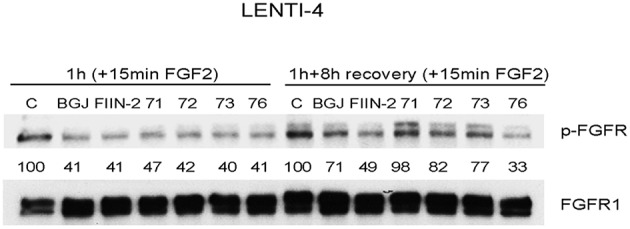
Inhibitory effects of UPR1371-UPR1376 on FGFR1 auto-phosphorylation in LENTI-4 cells. LENTI-4 cells, serum-deprived for 24 h, were pre-treated with 1 μM BGJ398, FIIN-2 or the newly synthesized FGFR inhibitors (UPR1371-UPR1376). After 1 h, the cells were stimulated with FGF2 for further 15 min, or extensively washed with PBS and stimulated with FGF2 for 15 min after 8 h of incubation in fresh drug-free medium. At the end of the treatments, the cells were lysed and the protein extracts were analyzed by Western blotting for FGFR1 auto-phosphorylation. Results are representative of three independent experiments. The immunoreactive spots were quantified by densitometric analysis, ratios of p-FGFR/total FGFR were calculated and values, expressed as percent vs. control, are reported.